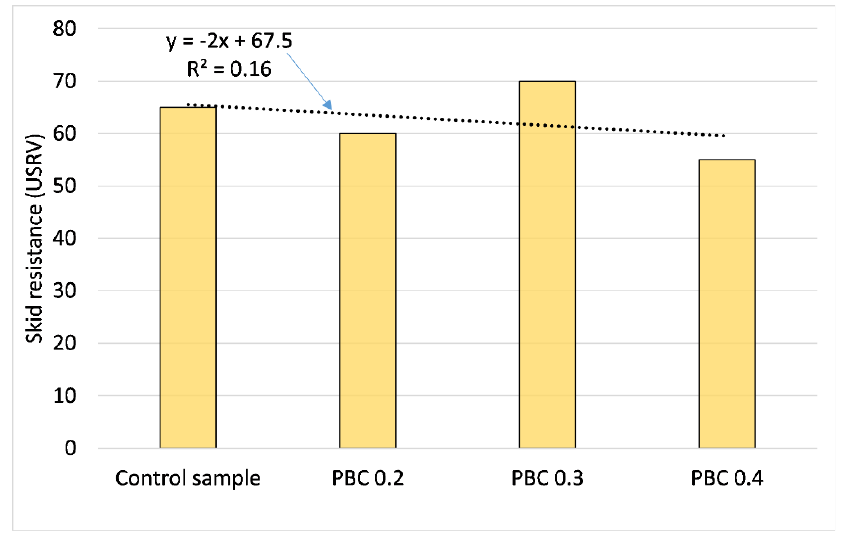
Figure 12. Skid resistance of CCF IPB at 28 days.